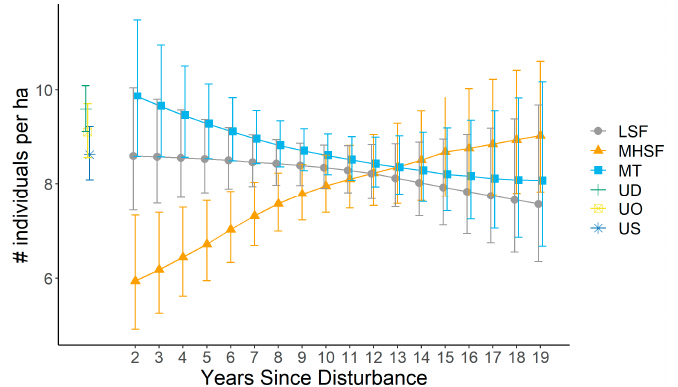
Figure 3. Total abundance (sum of all individuals across all species) over time. Abundance esti- mates were generated for each species within each disturbance type projected from characteristic vegetation values for tree cover, shrub cover, and snags (Figure A1), while holding all other model parameters constant. Error bars show the sum of 5% and 95% CIs for each species’ abundance esti- mate. MHSF = moderate-high-severity fire; LSF = low-severity fire; MT = mechanical treatment; UO = undisturbed open forest; US = undisturbed shrub; UD = undisturbed dense forest. A different pattern emerges when considering diversity among the different disturb- ance types (Figure 4). Moderate-high-severity fire locations had far higher diversity for